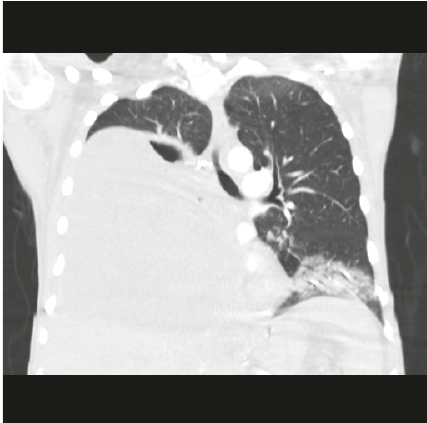
Figure 3: Left sided empyema and left lower lobe collapse prior to drainage.